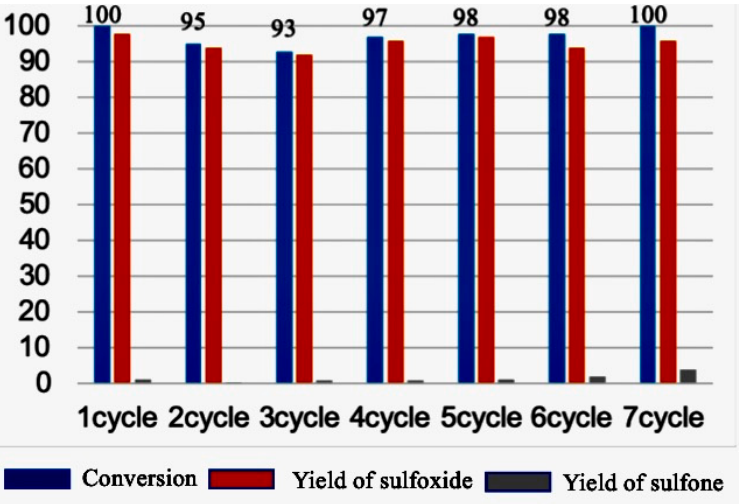
Figure 6. Recycling of Mn(TMPIP)/TiO 2 in the oxidation of thioanisole by O 2 in the presence of IBA. When oxidation of thioanisole was performed under homogeneous conditions re- placing Mn(TMPIP)/TiO 2 by its soluble counterpart Mn(TMPIP) or commercially avail- able ( meso -tetramesitylporphyrinato)manganese(III) chloride ( Mn(TMP) ) only starting thioanisole was observed in the reaction mixture after 24 h of reacting. When Mn(TMPIP) loading was increased up to 0.5 mol%, only 15% of thioalisole was converted to sulfoxide after 24 h. Thus, immobilization of Mn(TMPIP) on hydrated titania significantly increases its catalytic efficiency allowing us to perform sulfoxidation under ambient conditions. The